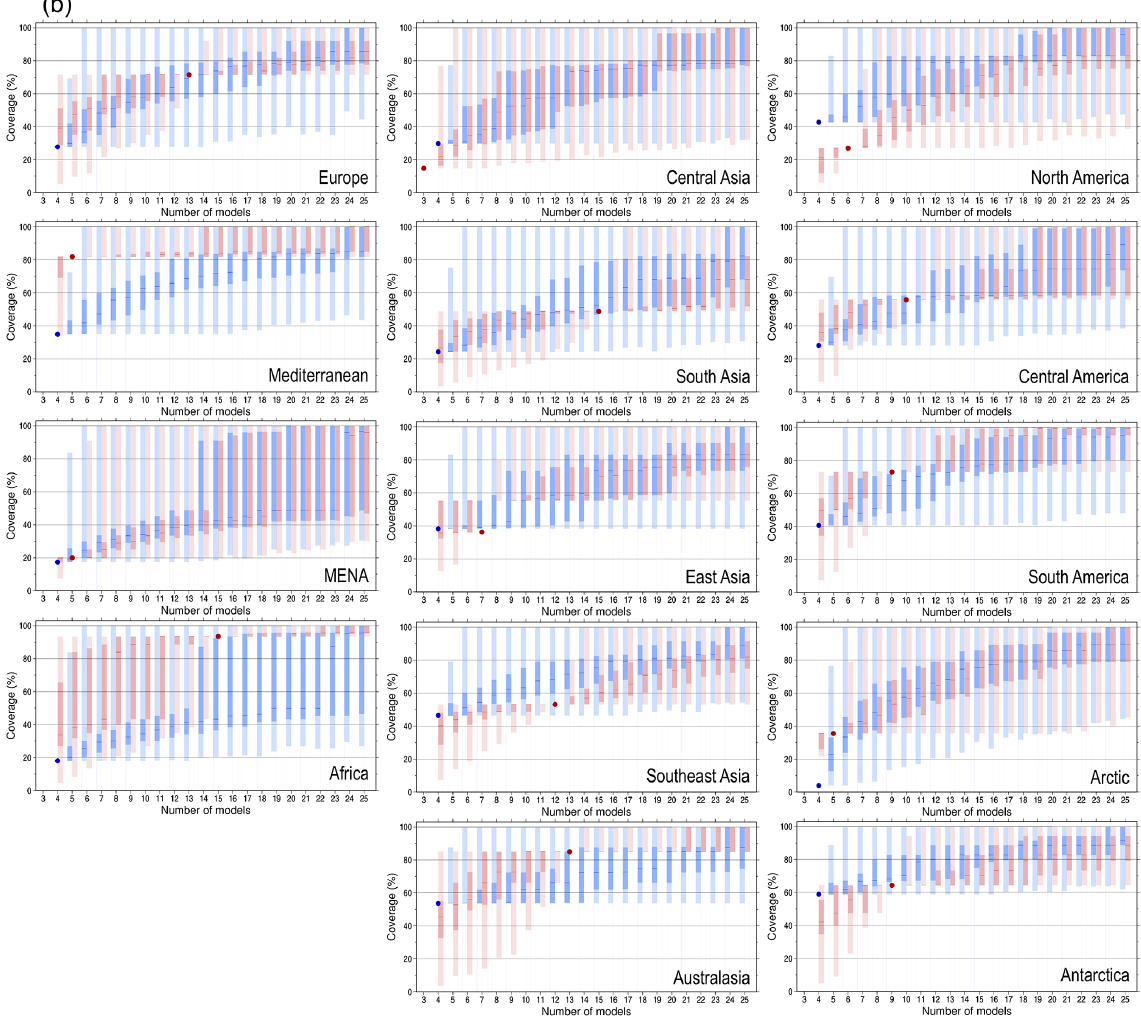
Figure 5. Change of coverage performance of the ISIMIP and CORDEX subsets depending on the number of selected models in each region for (a) annual mean temperature increment and (b) precipitation change scaled to the regional mean temperature increment. As Fig. 4, but the x axis denotes the number of selected